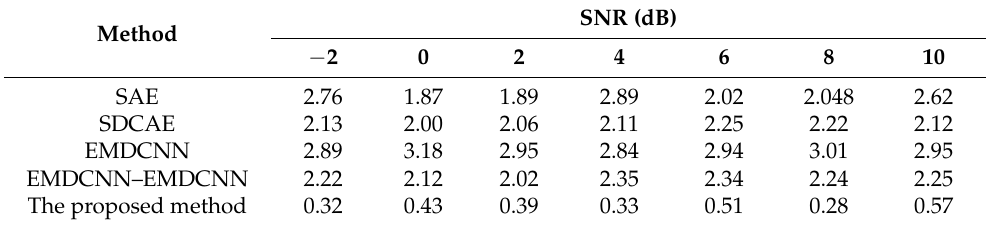
Table 3. Fault diagnosis standard deviation of different methods